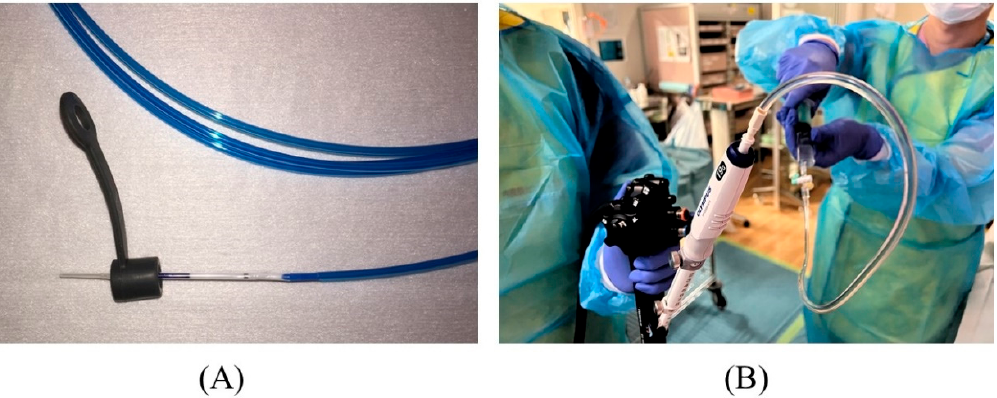
Figure 8. Preparation for puncture. The biopsy valve is attached to a dilation device ( A ). The needle stylet is removed, and a syringe filled with contrast medium is attached to the needle to pre-fill the lumen with contrast medium ( B ).